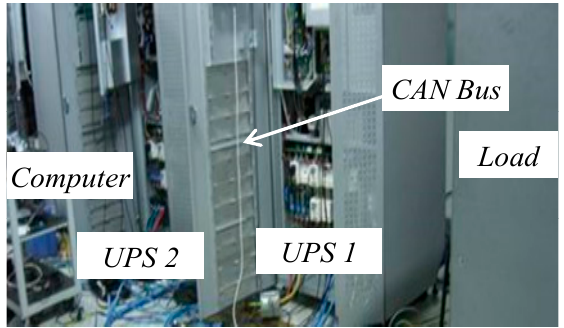
Figure 11. Photograph of experimental prototype of two-inverter parallel system. Experiment I